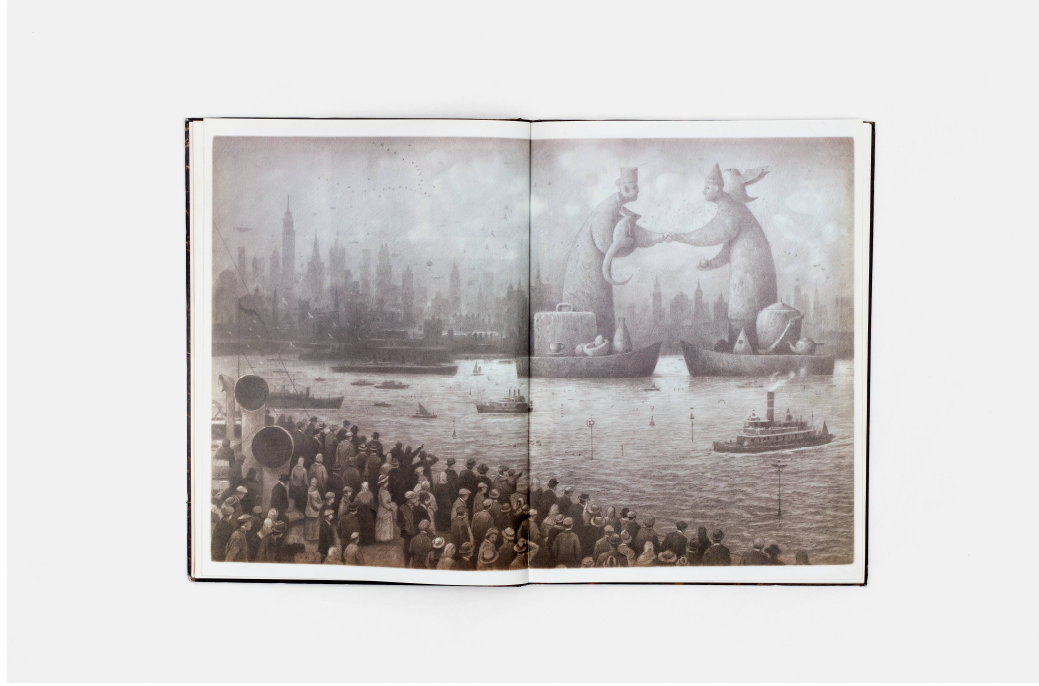
Figure 7. Tan S. (2016), L’approd o, Tunuè,